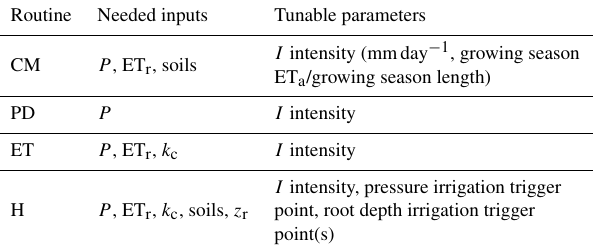
Table 1. Summary of needed inputs and tunable parameters for each irrigation